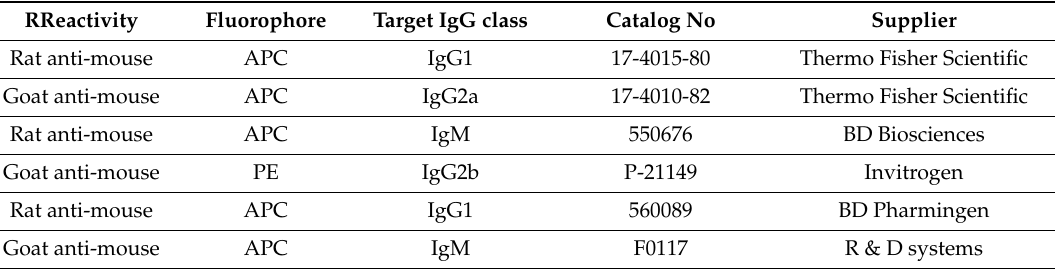
Table 2. List of secondary